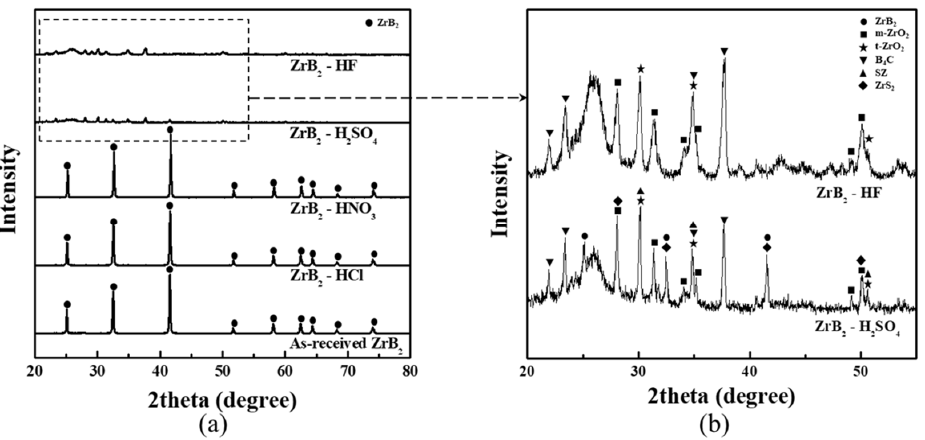
Figure 1. X-ray diffraction (XRD) patterns of different samples. ( a ) XRD patterns of as-received ZrB 2 particles and acid-treated ZrB 2 particles and ( b ) the specific part of XRD patterns of HF- and H 2 SO 4 -treated ZrB 2 .